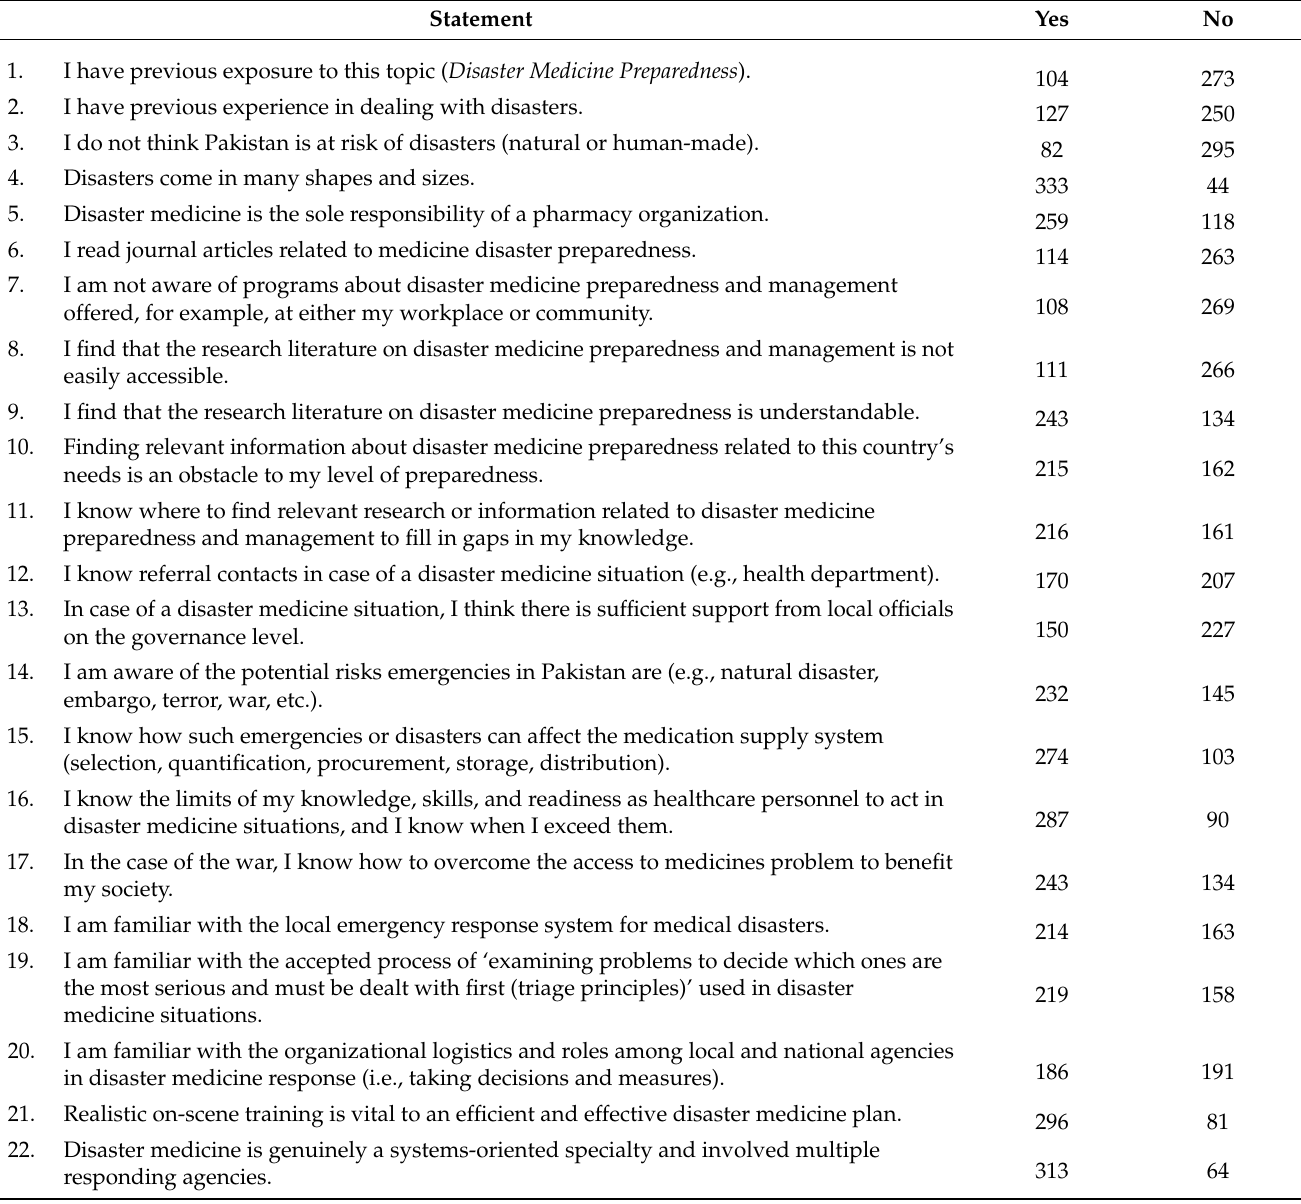
Table 2. Knowledge assessment of the respondents regarding disaster medicine